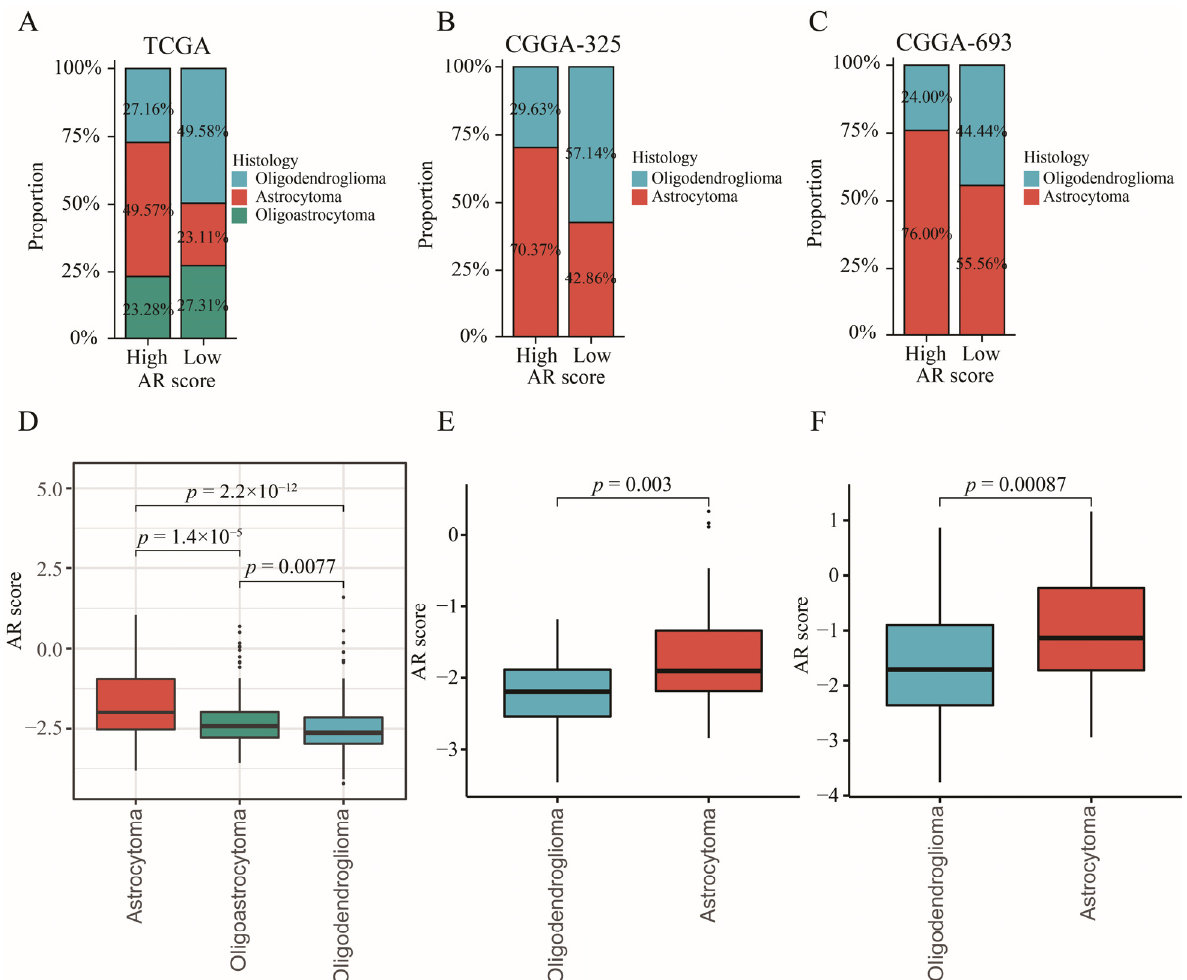
Figure 9. The relationship between AR-related signature and histology. ( A – C ) The proportion of histological distribution between high- and low-AR groups in TCGA, CGGA-325, and CGGA-693, respectively. ( D – F ) The comparisons of AR scores in different histological subtypes in TCGA, CGGA-325, and CGGA-693, respectively.